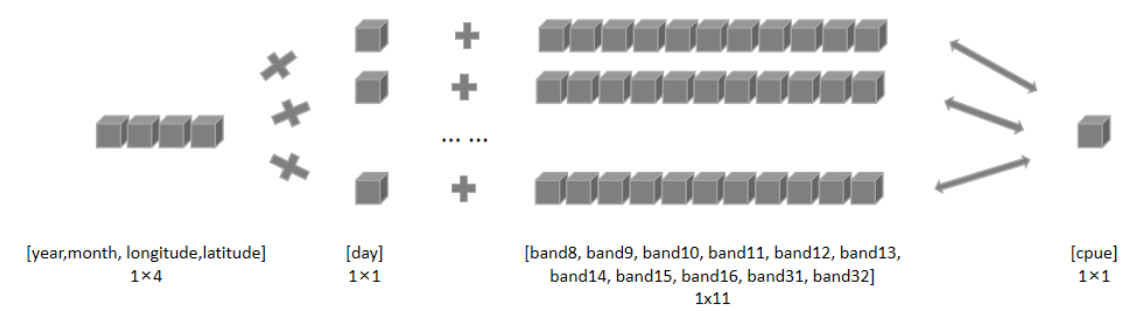
Figure 6. L1B_Fishery data structure.